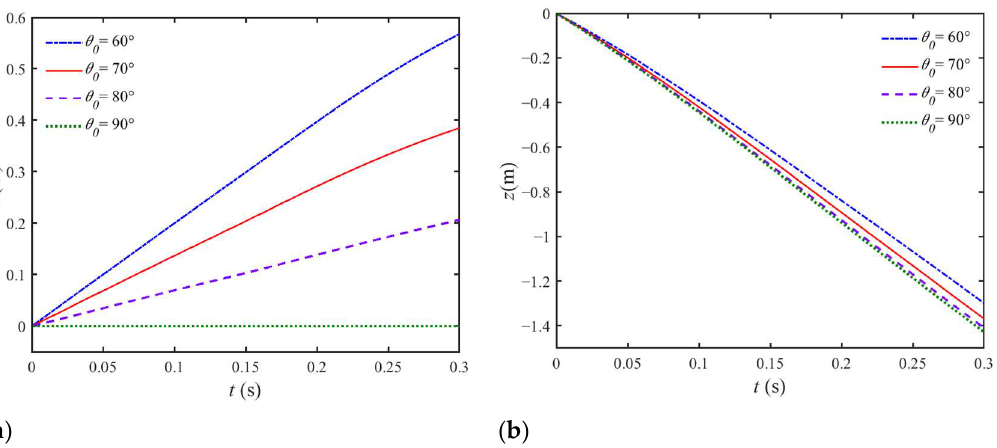
Figure 19. Comparison of time history curve of ( a ) horizontal translation and ( b ) vertical translation for the water entry of UAUV with different initial pitch angles.